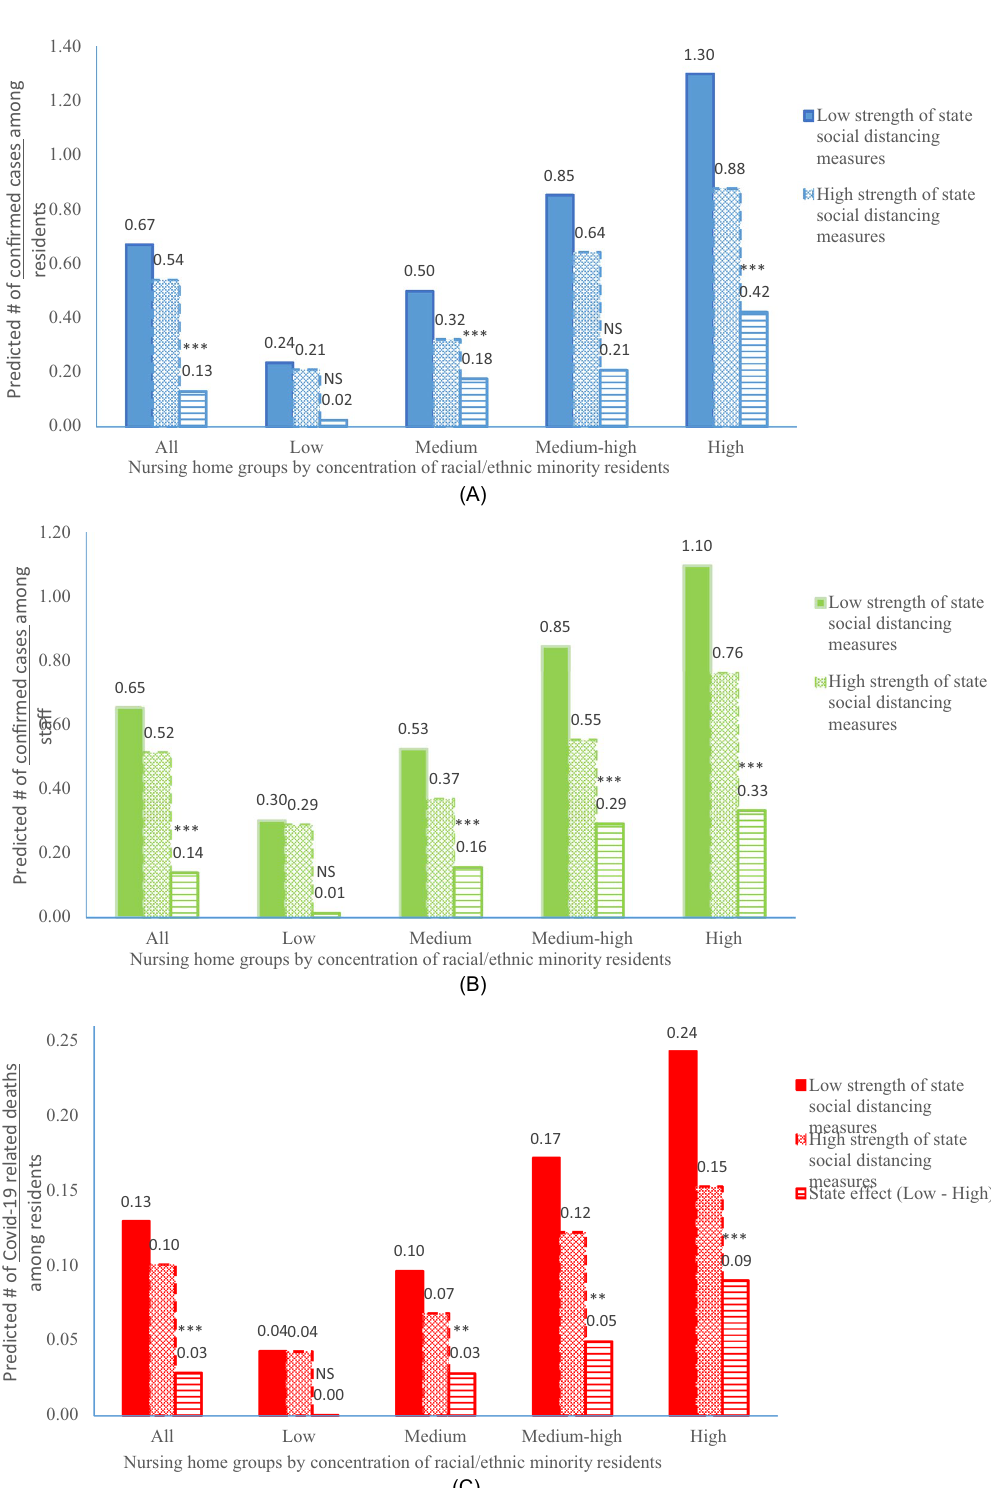
Figure 1. Predicted numbers of ( A ) weekly new laboratory-confirmed COVID-19 cases among residents, ( B ) new weekly laboratory- confirmed COVID-19 cases among staff, and ( C ) new weekly COVID-19 related deaths among residents reported in U.S. nursing